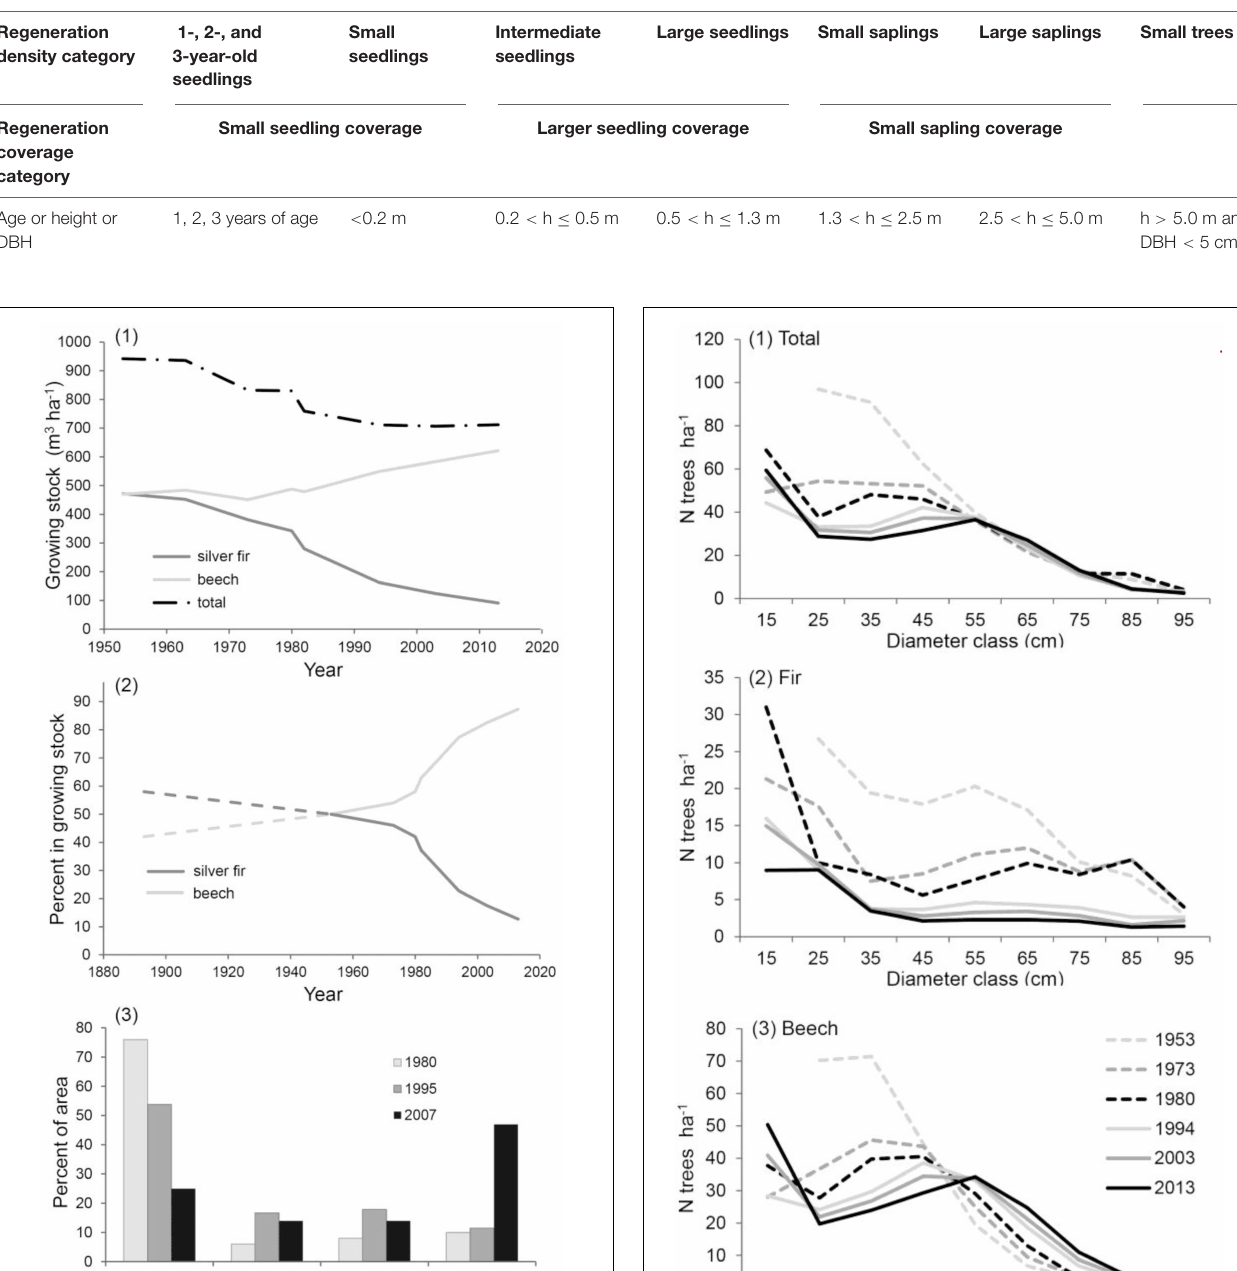
TABLE 1 | Age and height categories of the sampled regeneration.